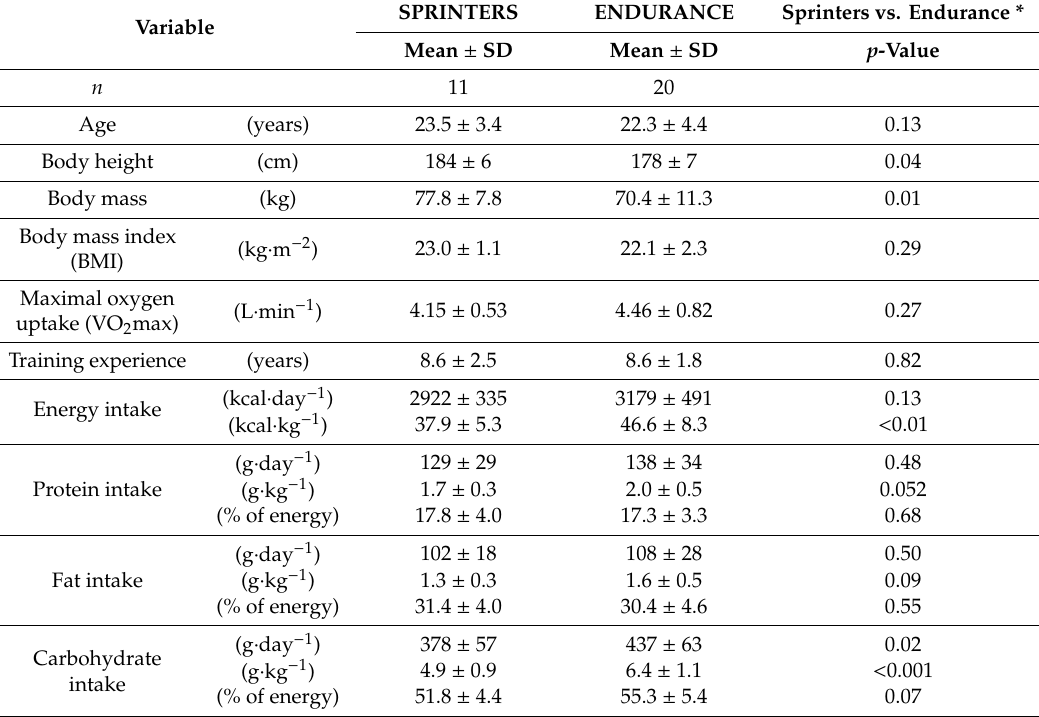
Table 1. Baseline anthropometric, training, and diet characteristics of the studied